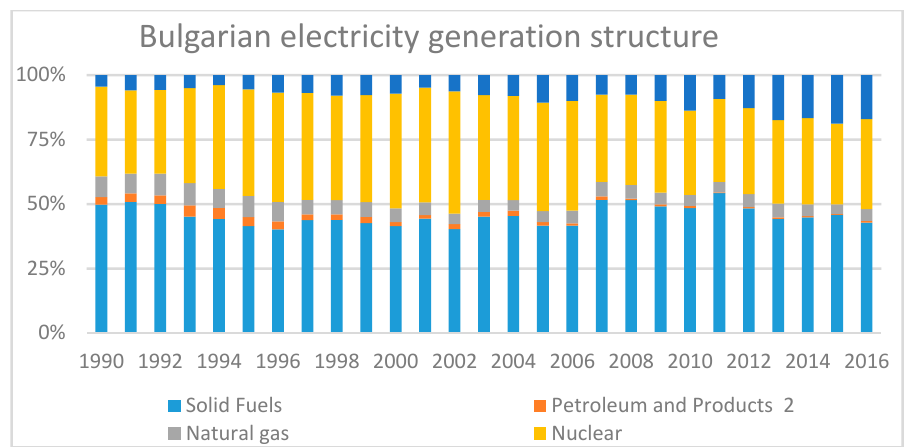
Figure 11. Electricity generation structure dynamics in Lithuania, %. Source: [39].